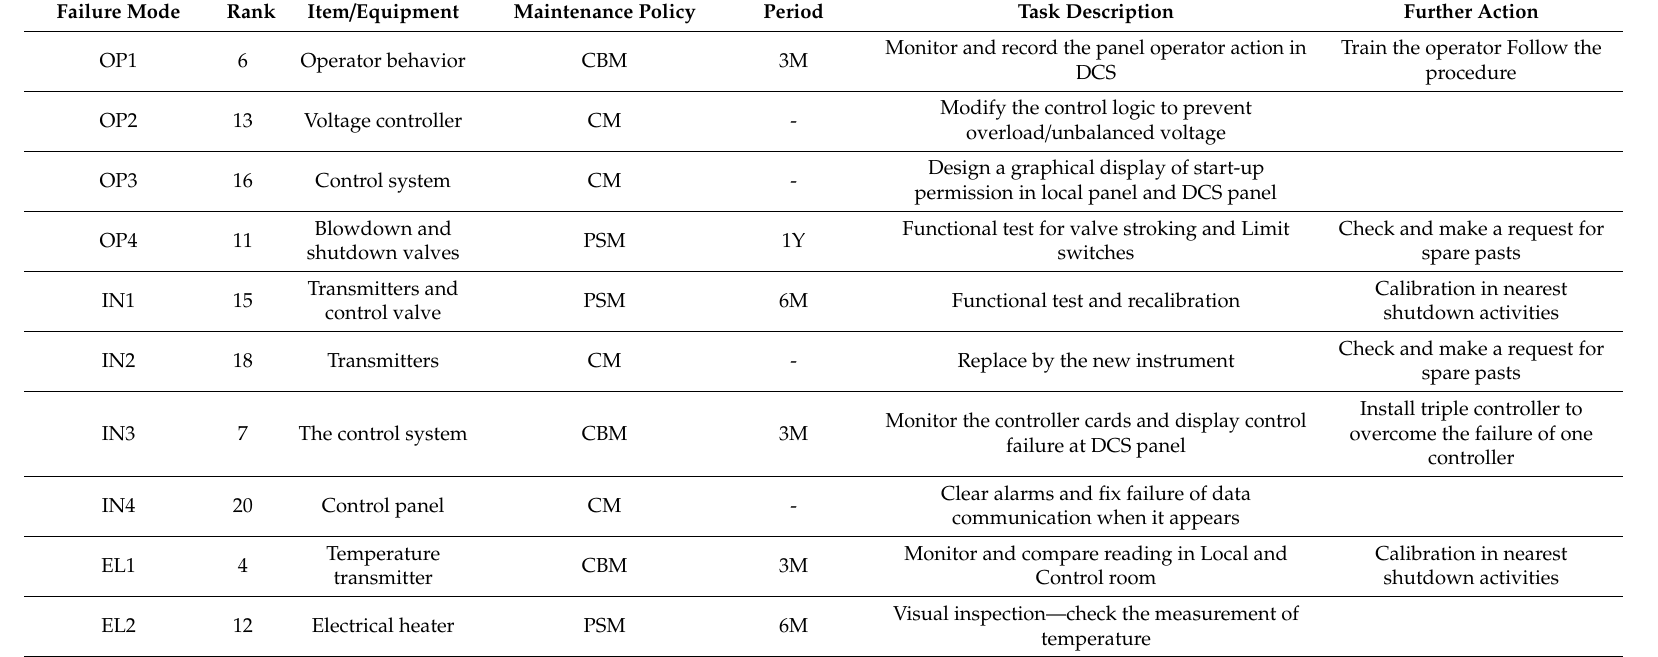
Table A1. The selected maintenance policies and scheduling of the proposed RCM